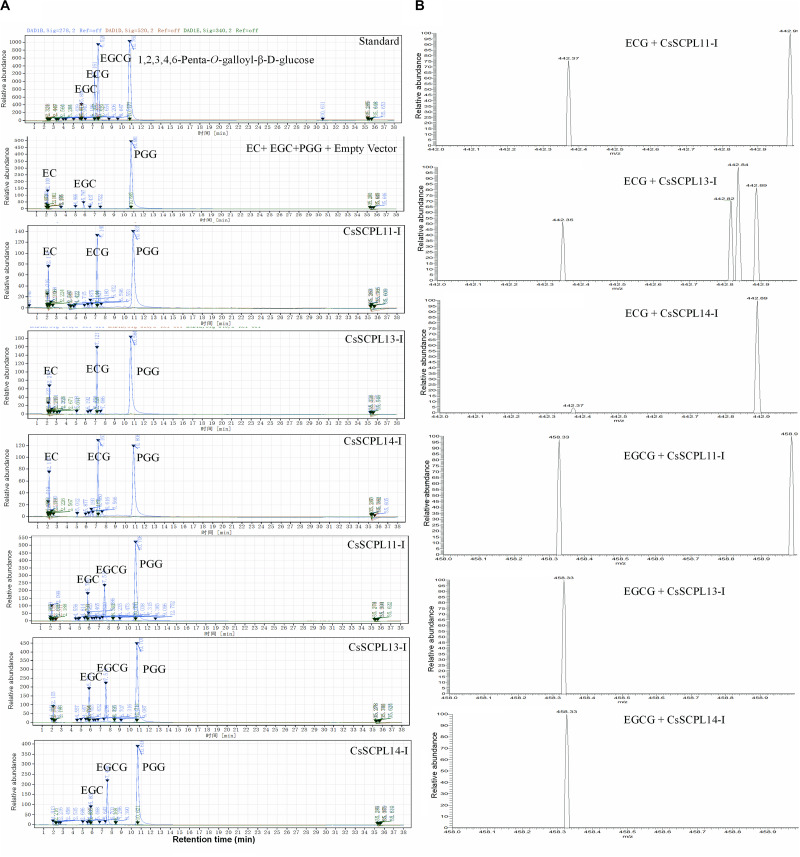
Activity assay of recombinant CsSCPL11-IA, 13-IA, and 14-IA. (A) HPLC verification of activity assay with epicatechine (EC), epigallocatechine (EGC) and 1,2,3,4,6-Penta-O-galloyl-β-D-glucose (PGG). (B) LC-MS spectra of CsSCPL11-IA, L13-IA and 14-IA activity assay products. ECG, Epicatechin gallate; EGCG, Epigallocatechin gallate. Analytical data were obtained from atleast three biological replicates.